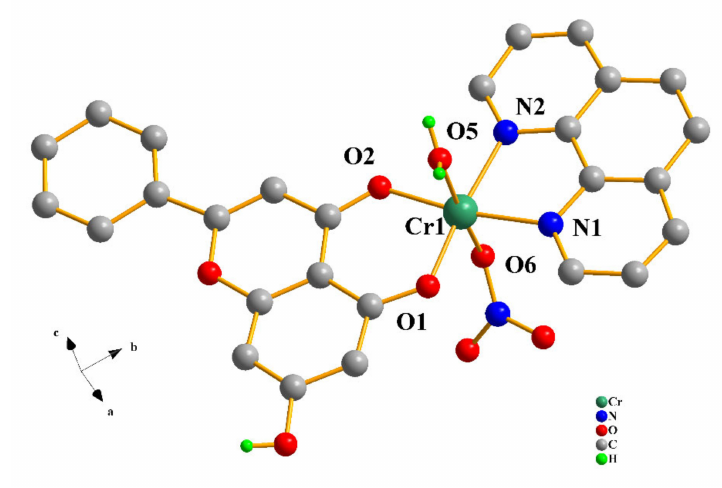
Figure 2. Diamond diagram of the cationic assembly [Cr(C 15 H 9 O 4 )(C 12 H 8 N 2 )(H 2 O)(NO 3 )] + in compound 2 . Hydrogen atoms connected to sp 2 carbons are